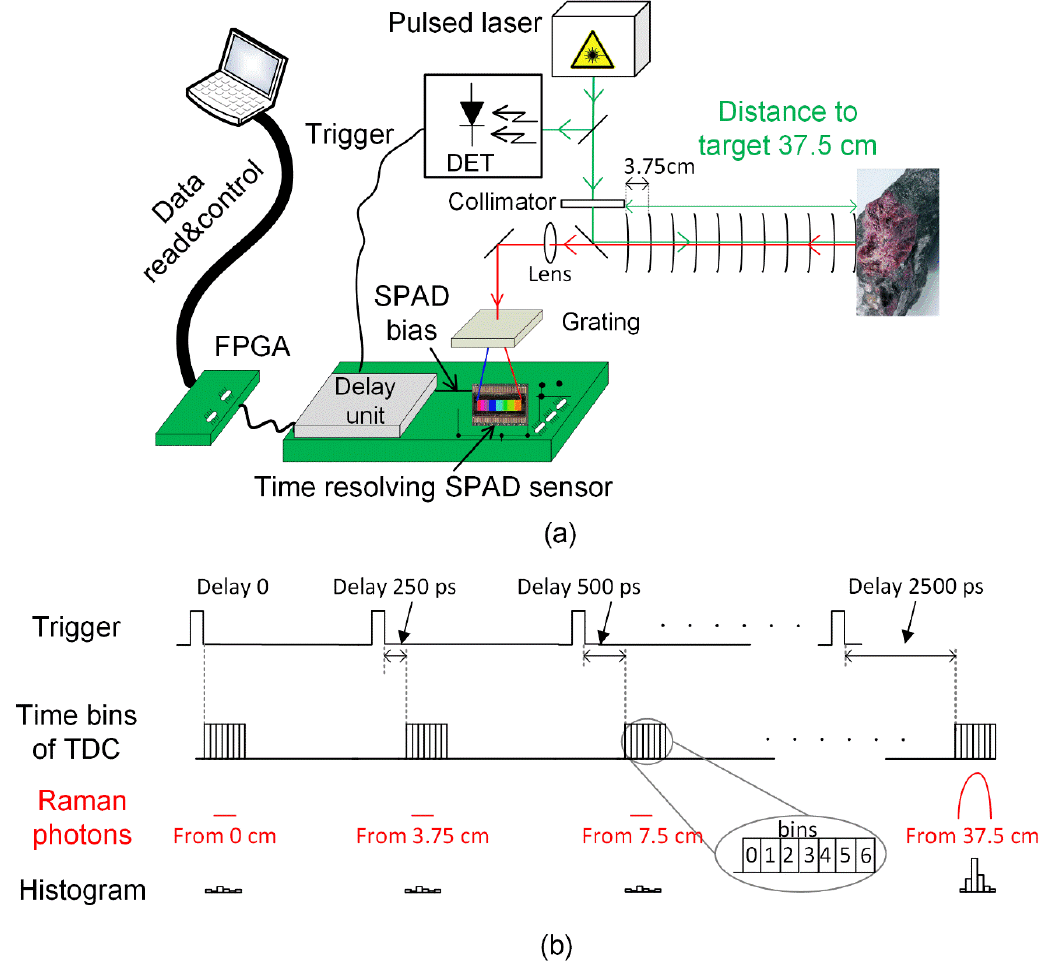
Figure 2. ( a ) Block and ( b ) timing diagrams for the distance-resolving Raman radar based on a time- correlated complementary metal-oxide-semiconductor (CMOS) single-photon avalanche diode (SPAD)